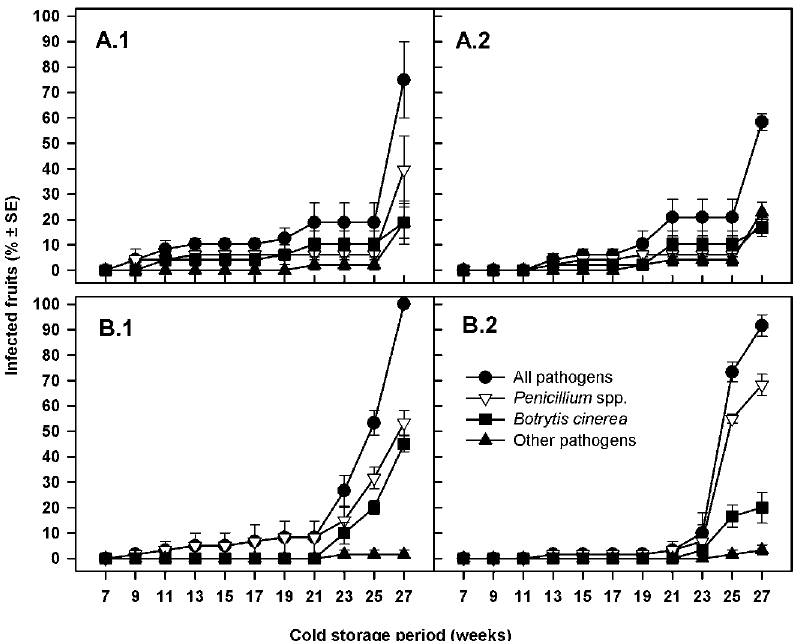
Figure 5. Incidence of postharvest diseases caused by different pathogens on commercially-handled pomegranates cv. Mol - lar de Elche from two orchards (1 and 2). The fruit were stored at 5ºC and 90% RH for 27 weeks. Data from two consecutive seasons, 2005 and 2006 (A and